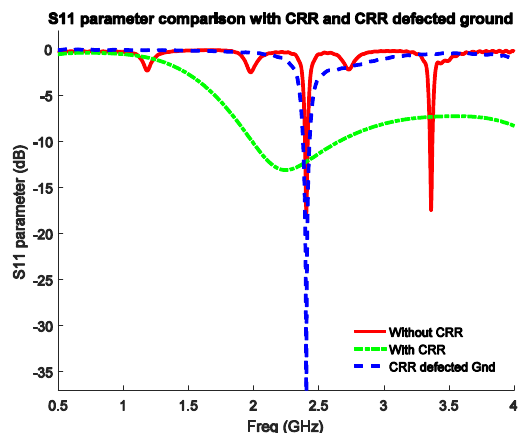
Figure 7: S11 parameter for planar patch with and without CRR loading.